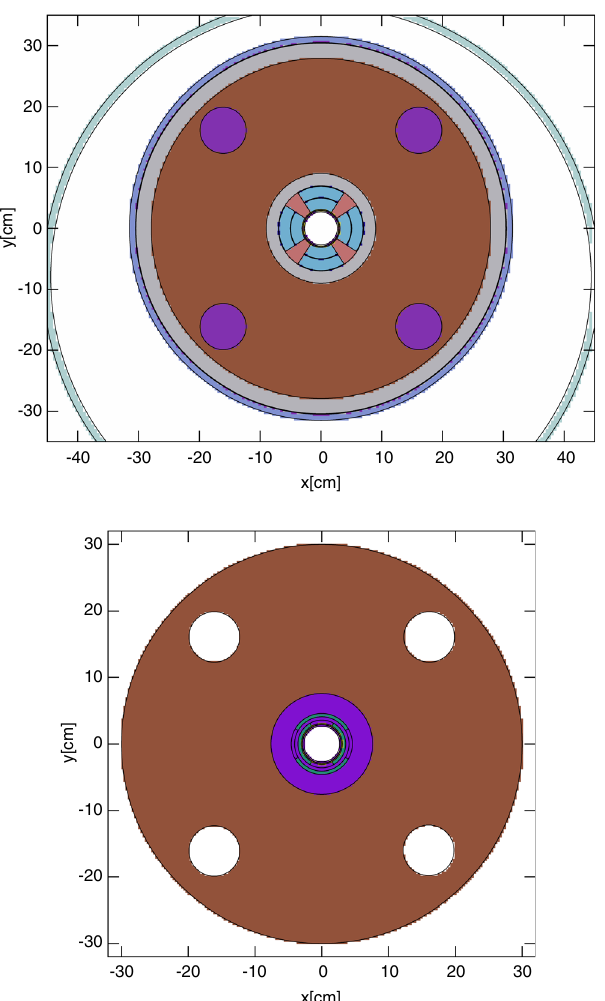
FIG. 3. Magnet cross sections: quadrupole (top) and orbit corrector